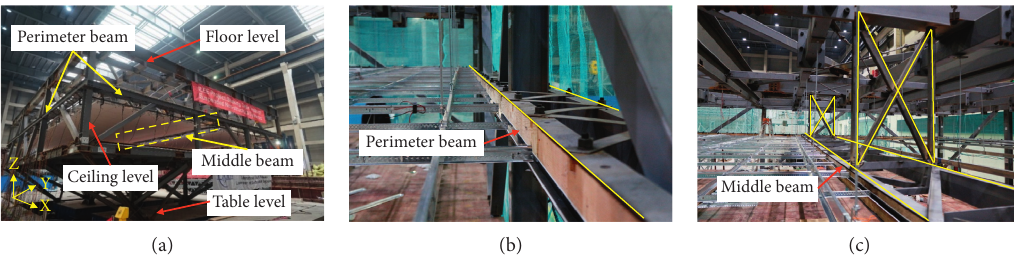
Figure 4: Test setup. (a) Overall view of steel platform, (b) perimeter beam, and (c) middle beam.